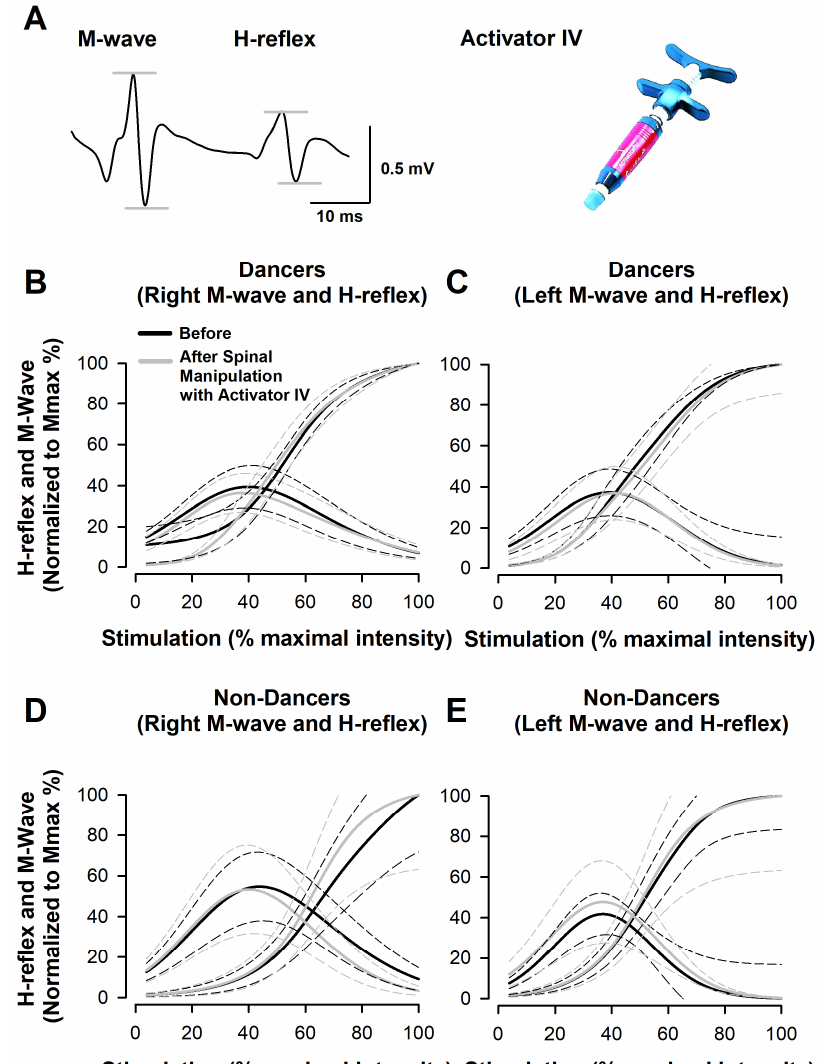
Figure 1. ( A ) Typical recording of an M ‐ wave and H ‐ reflex, and an illustration of the Activator IV instrument. ( B – E ) Pooled data. Overall average of fitted recruitment curves for M ‐ waves and H ‐ reflexes recorded in dancers: ( B ) from the right soleus muscle and ( C ) from the left soleus muscle. ( D , E ) The same as ( B , C ) but for non ‐ dancers. M ‐ wave data were best fitted by a sigmoid nonlinear regression model of three parameters. On the other hand, H ‐ reflex data were best fitted by a Gaussian nonlinear regression model of three parameters. Solid lines portray the overall average and dashed lines depict the standard error.